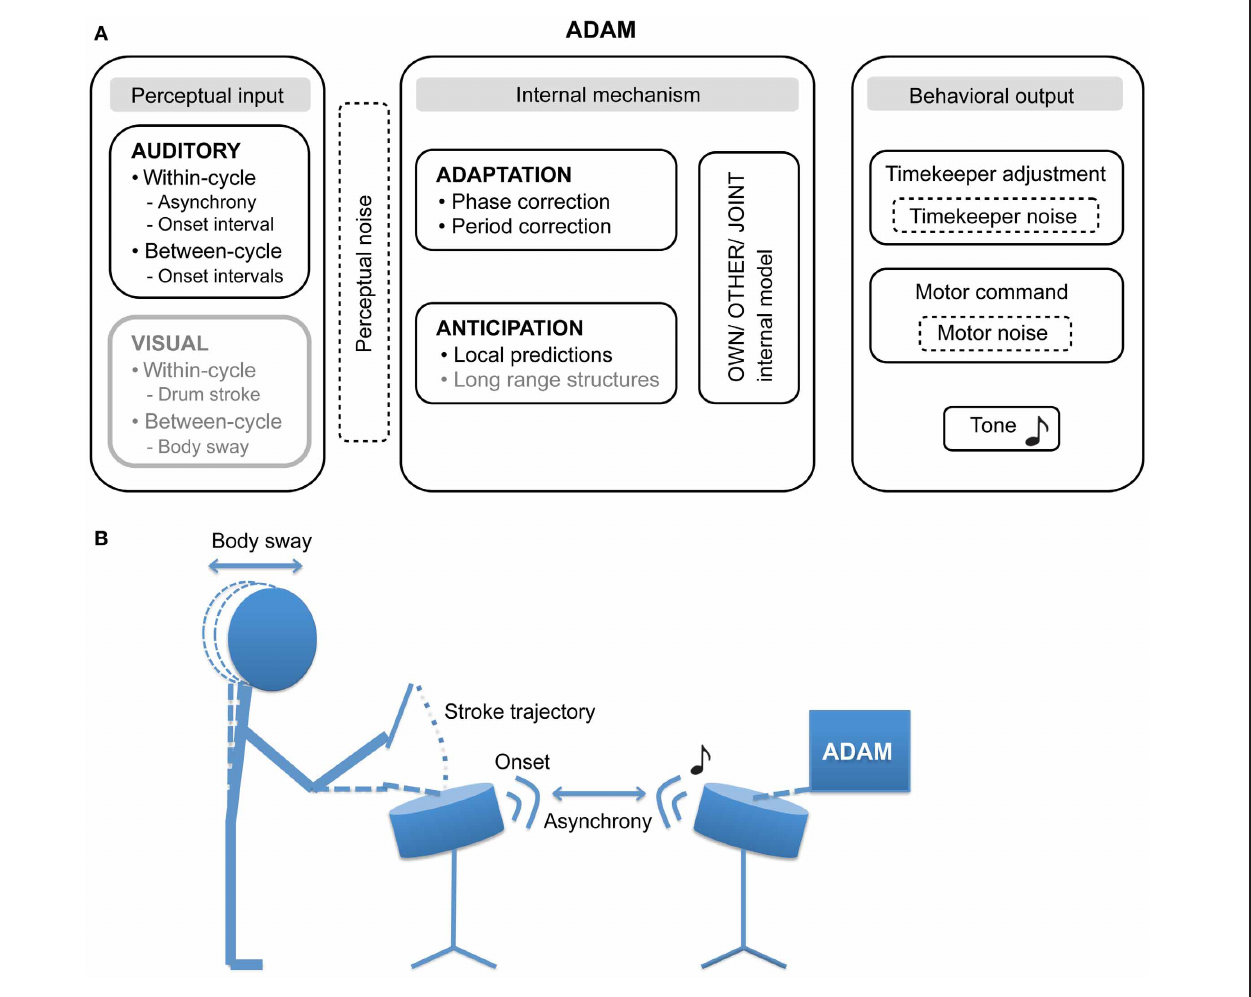
FIGURE 1 | (A) The proposed architecture of the ADaptation and Anticipation Model, ADAM. The main components that are illustrated include auditory and visual input, internal mechanisms that support adaptation to and anticipation of this input, and—by communing with internal models of one’s own actions, others’ actions, and collective joint actions—control behavioral output. In addition, three sources of noise